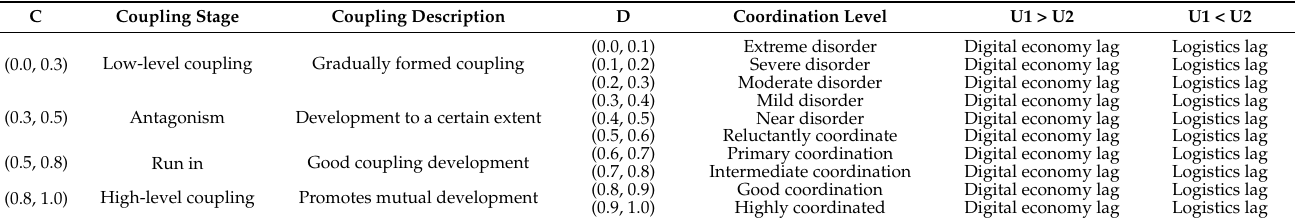
Table 2. The classification of CD and